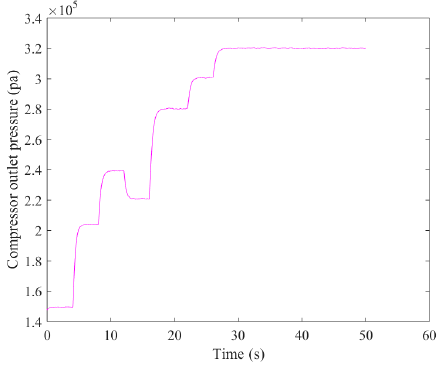
Figure 5. Compressor speed changes with time.